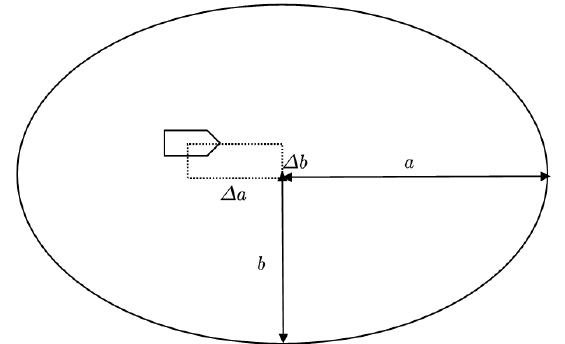
Figure 4. A decentralized elliptic ship domain.